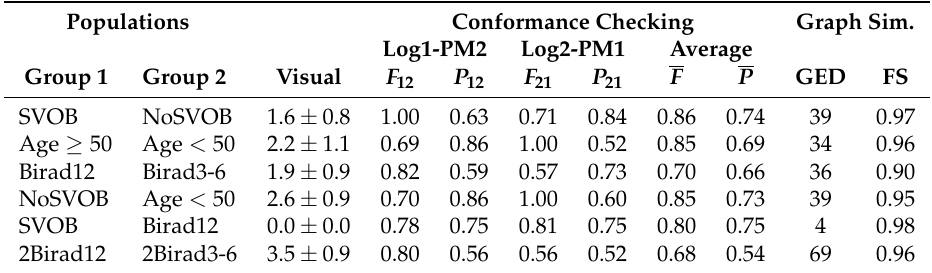
Table 7. Process comparison on ZGT. Visual impression (Visual), conformance checking metrics (F—Fitness, P—Precision) when group 1 event log is checked against the process model (PM) constructed for group 2 and vice versa. Graph similarities (GED—graph edit distance, FS—feature-based similarity) Populations Conformance Checking Graph Sim. Log1-PM2 Log2-PM1 Average Group 1 Group 2 Visual F 12 GED SVOB NoSVOB Birad12 0.0 ±